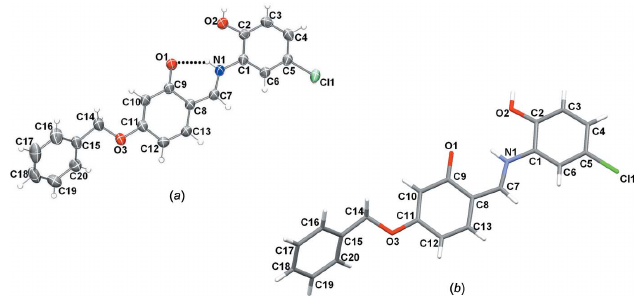
Figure 8 Comparison of the structures of (II) obtained from ( a ) the X-ray determination and ( b ) the DFT calculations.